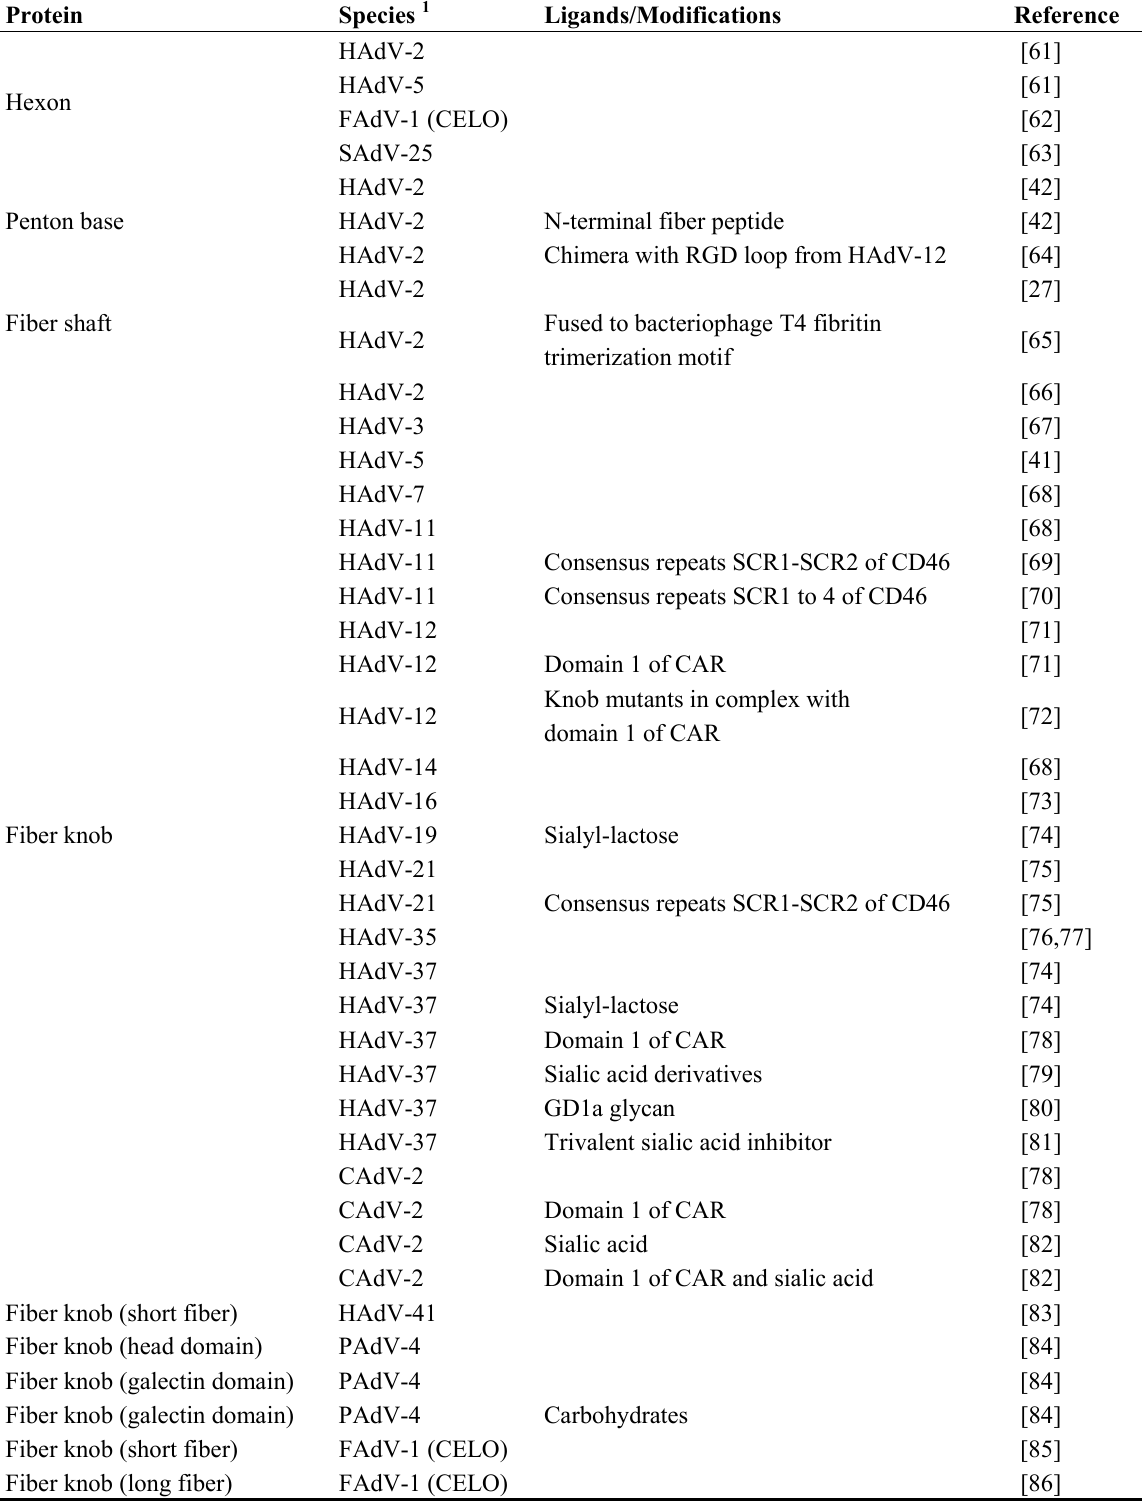
Table 1. Structures of AdV capsid proteins solved by X-ray